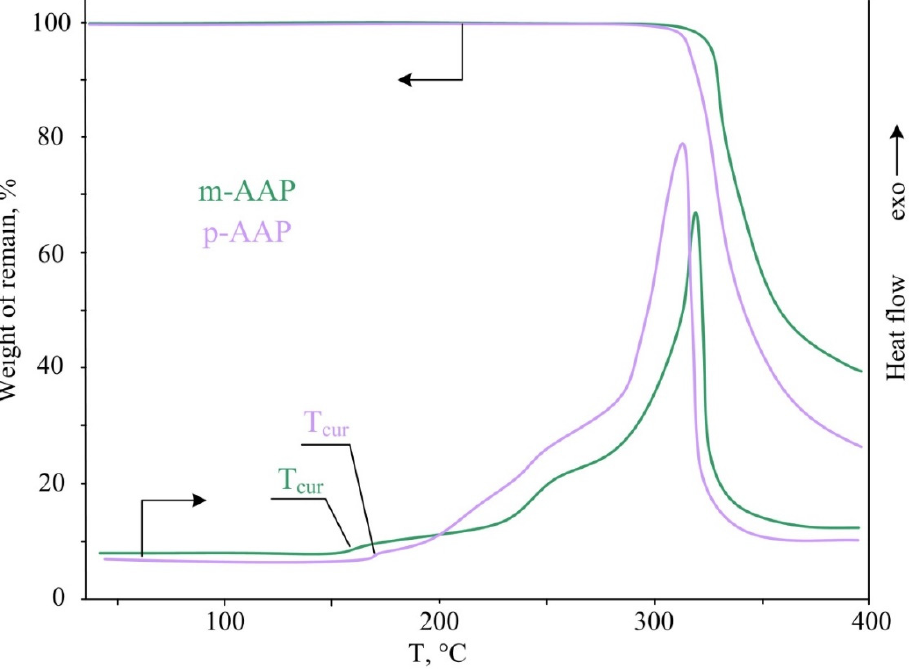
Figure 8. TGA and DSC thermogram of compositions based on DER-331 containing 15 mass. % m- or p-AAP (arrows show which scale corresponds to which thermograms).